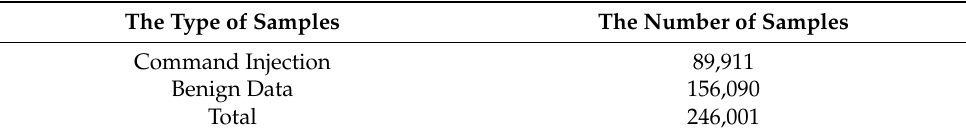
Table 1. The statistics of